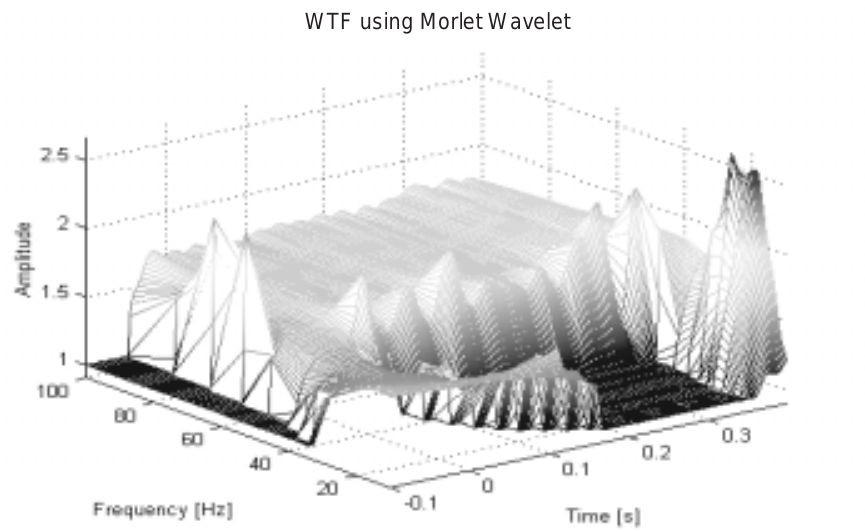
Fig. 7. WTF no clipping of the transient response of the healthy beam using sensors S1 and S2.